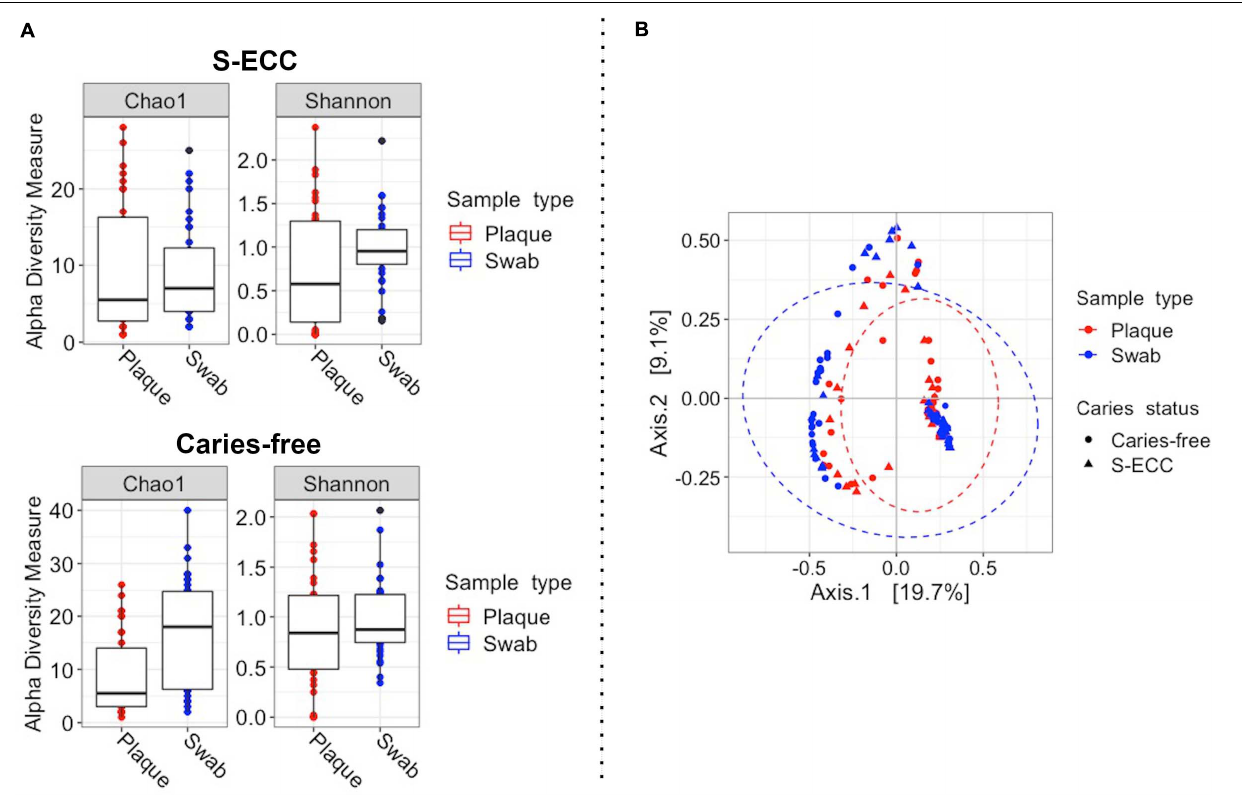
FIGURE 4 | Fungal diversity of dental plaque and oral swab samples. (A) For alpha diversity (within-sample) the Shannon and Chao1 diversity and richness measures were calculated according to sample type in both caries-free and S-ECC groups. A significant difference in richness was observed between the sampling sites in the caries-free group ( P < 0.001, Chao1 index, paired Wilcoxon test). (B) For beta (between-sample) diversity, Bray-Curtis distances were calculated, followed by principal coordinates analysis (PCoA, pseudo-F = 11.58, R 2 = 0.04, P = 0.001, PERMANOVA). The ellipses represent a 95% confidence level. S-ECC, severe early childhood